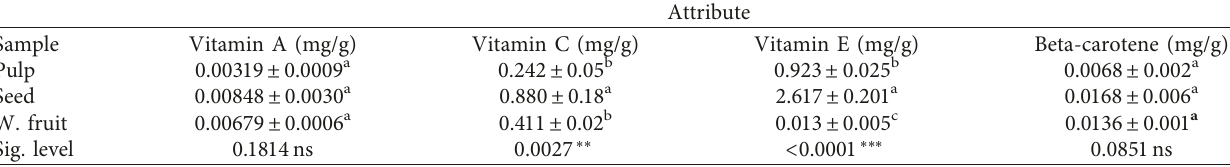
Table 1: Vitamin A, C, and E and beta-carotene composition in pulp, seeds, and whole fruit of T. tetraptera .